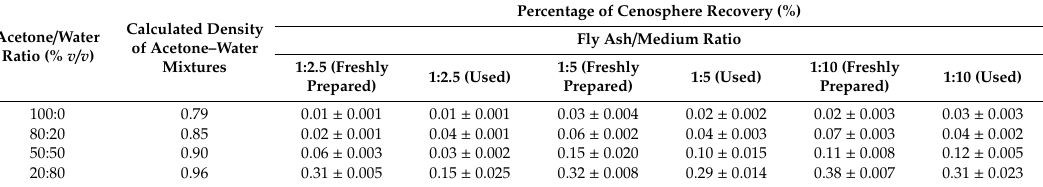
Table 1. Calculated density of acetone–water mixtures at di ff erent ratios of acetone and water, the percentage of cenosphere recovery of cenospheres collected from using di ff erent ratios of